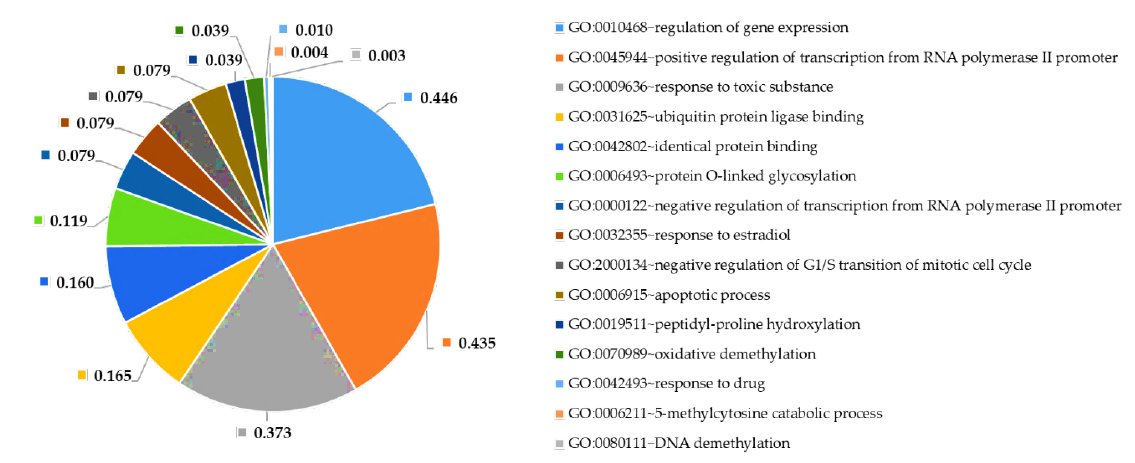
Figure 4. Functional annotation enrichment of target genes of the top 38 deregulated miRNAs based on their enrichment in Gene Ontology GO_ Biological Processes. Significance of the selected (?) pathways are characterized by their FDR values shown inside the chart sections.